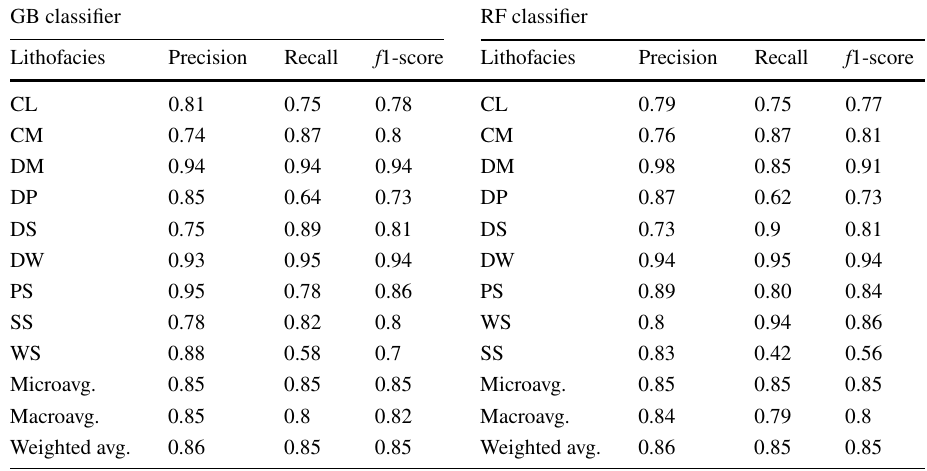
SVM and MLP classifiers after tenfold cross-validation for lithofacies classification